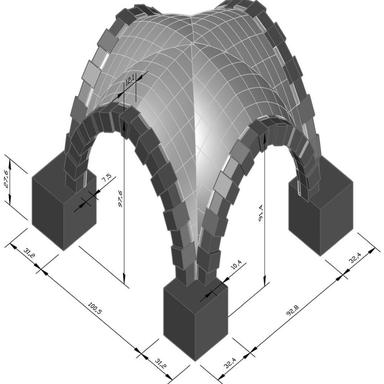
The 1:5 scale vault tested at the University of Florence (measures in cm).